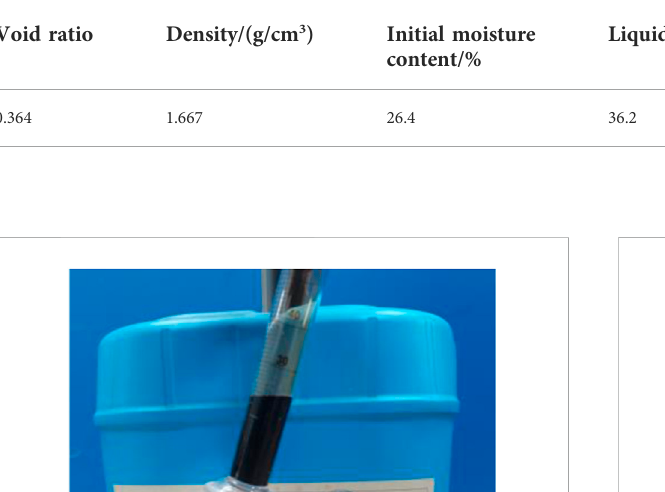
TABLE 1 Basic physical properties of soil.